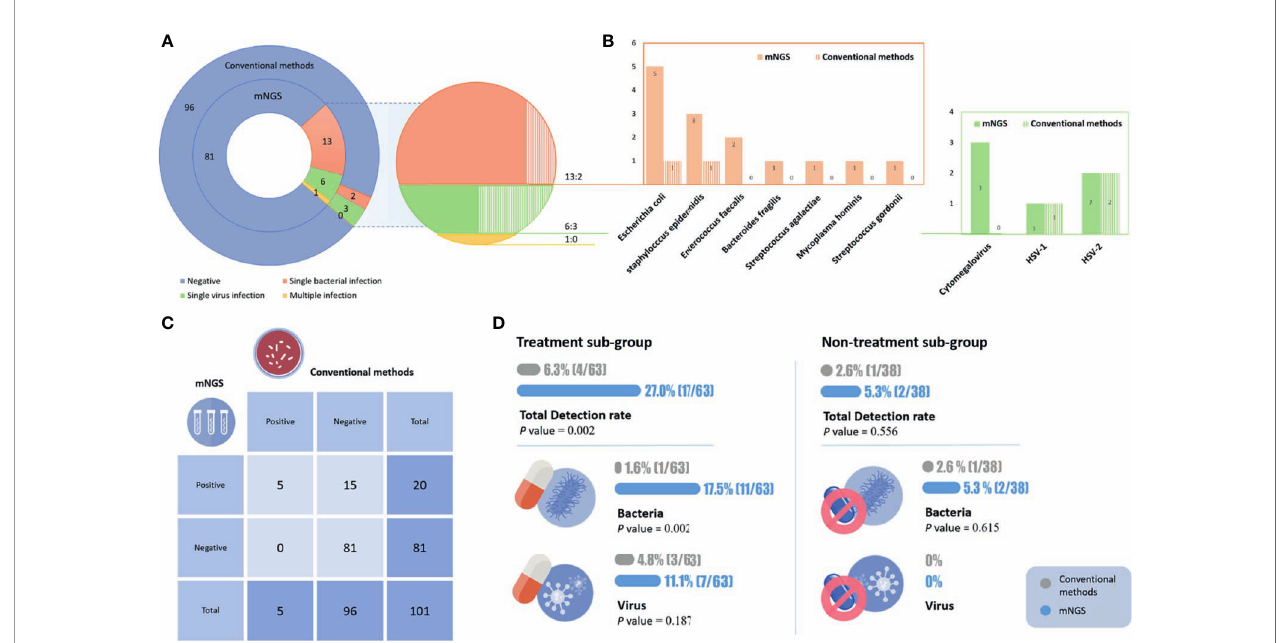
FIGURE 2 | (A) The results of mNGS and conventional tests. (B) Distribution of pathogens identi fi ed by mNGS and conventional tests. (C) Comparison of mNGS and conventional methods. (D) The detection rate of the different methods in the two subgroups. In the empirical treatment group, the detection rate of mNGS was signi fi cantly higher than that of conventional methods, especially for bacterial infections.